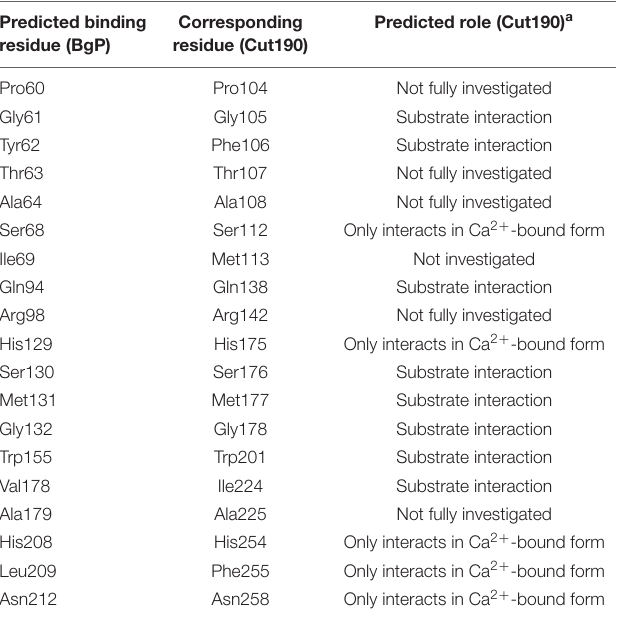
TABLE 4 | Comparative analysis of potential BgP binding residues, as predicted by 3DLigandSite, and the matching residue found at the same location in Cut190. Predicted binding residue